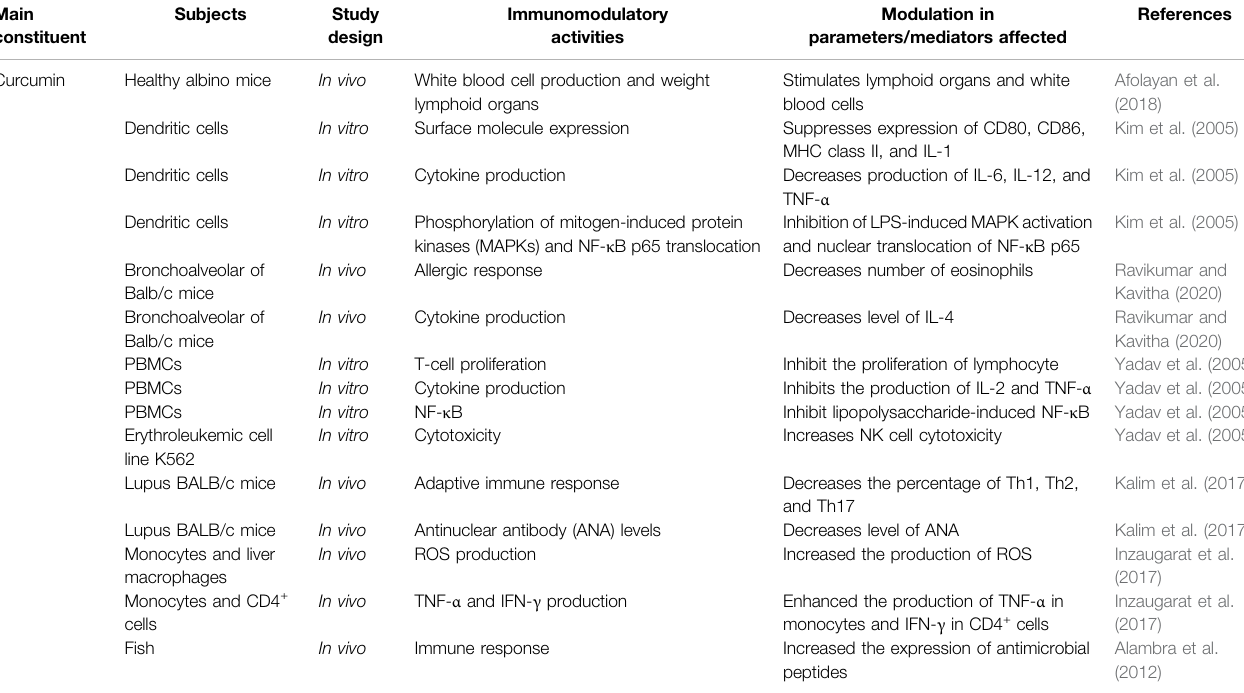
TABLE 2 | Curcumin of C. longa with immunomodulating activity and their mechanisms of action. Main